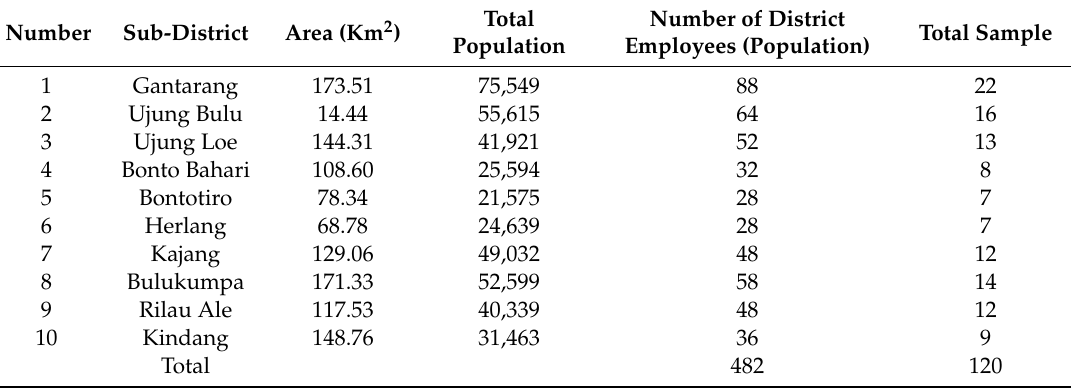
Table 1. Number of Respondents by Subdistrict in Bulukumba